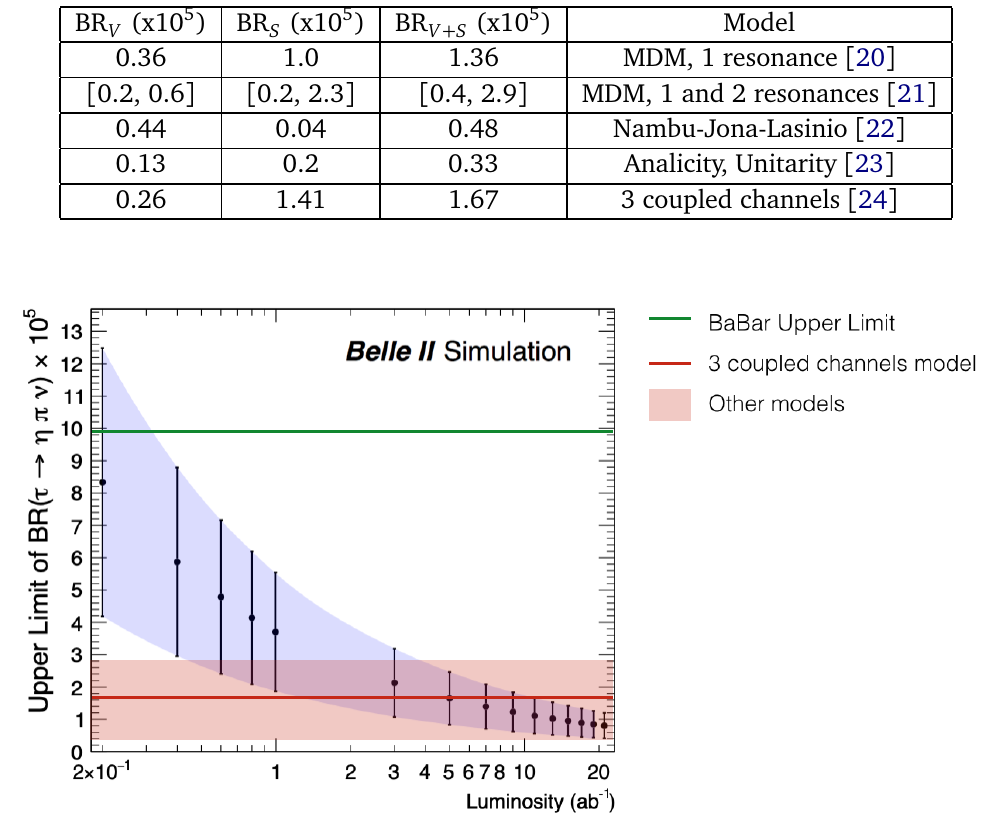
Table 1: Most recent SM predictions of the branching ratio of the decay τ → ηπν τ .